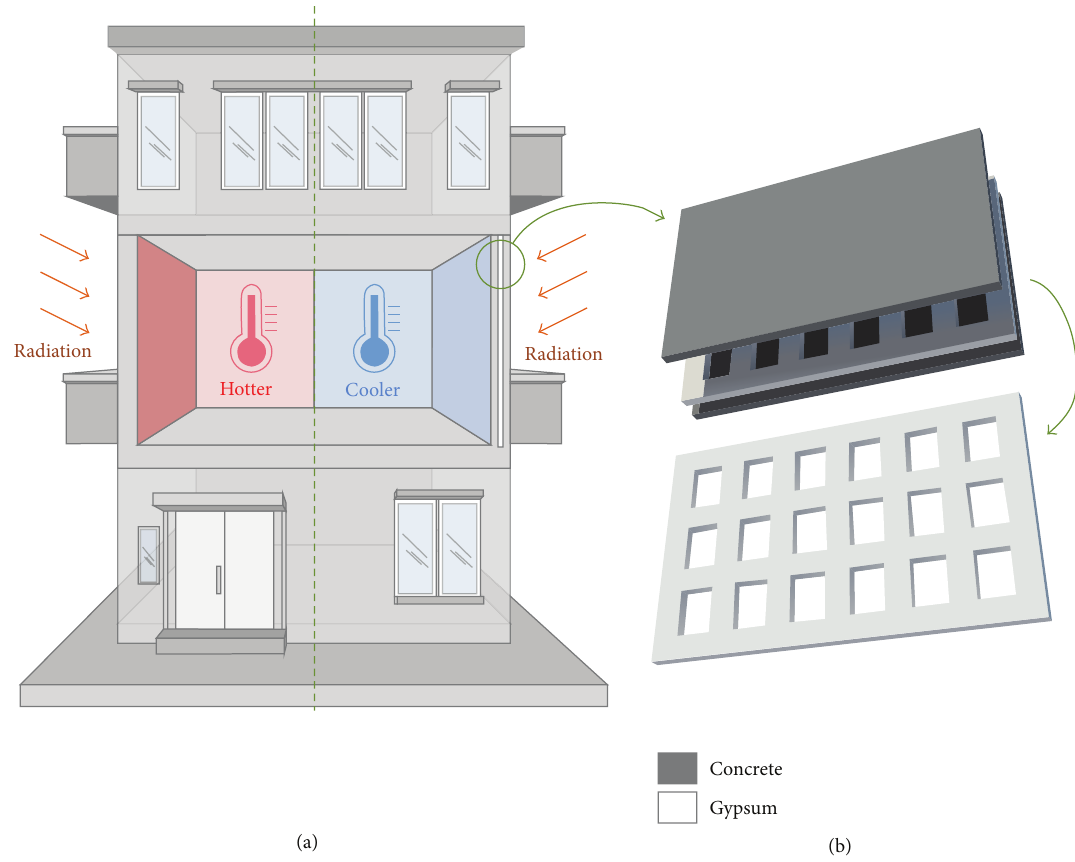
Figure1:(a)Theleftpartofthebuildingenvelopesisconstructedbytheconventionalprecastconcretewallpanel,whiletherightpartemploys the proposed new wall panel design. If there is no air-conditioning system, a building structure adopting the new wall panel will exhibit a lower indoor temperature than that of a conventional concrete building; (b) a schematic diagram of the sandwich concrete/gypsum wall panel which shows the gridded gypsum